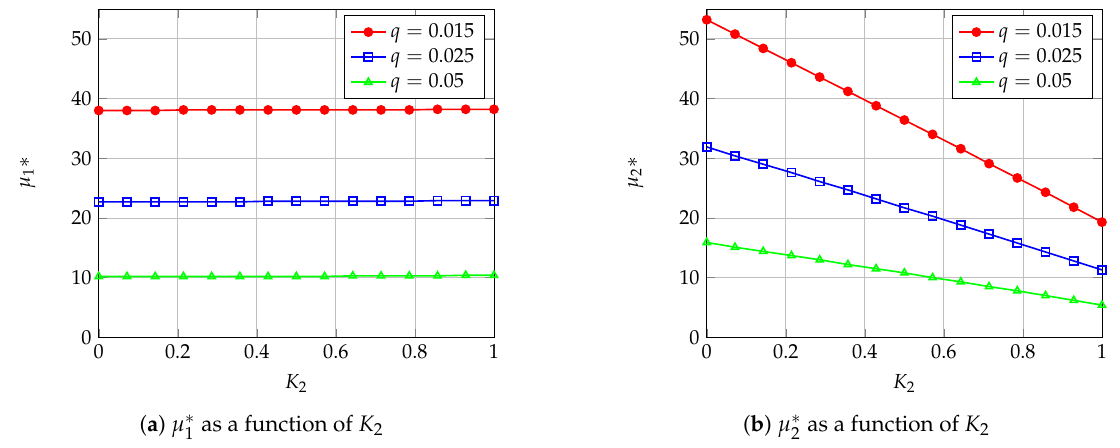
Figure A2. MNOs network capacity as a function of K 2 with K 1 = 0.45.